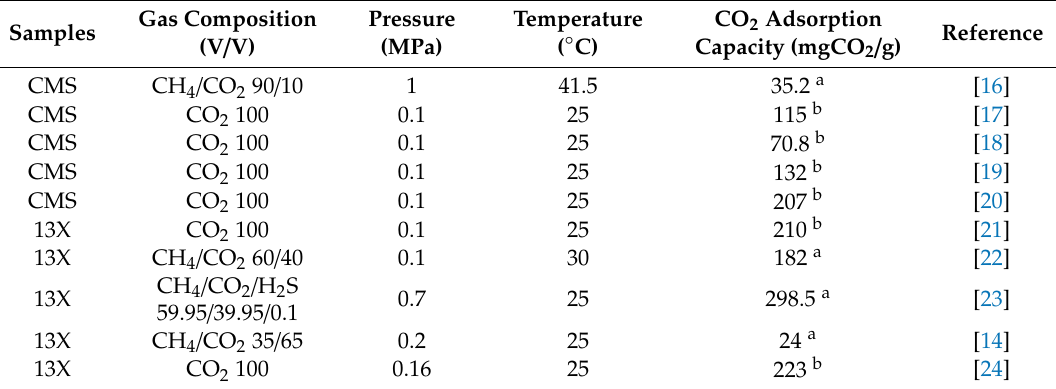
Table 1. Adsorption capacity of CO 2 on di ff erent molecular